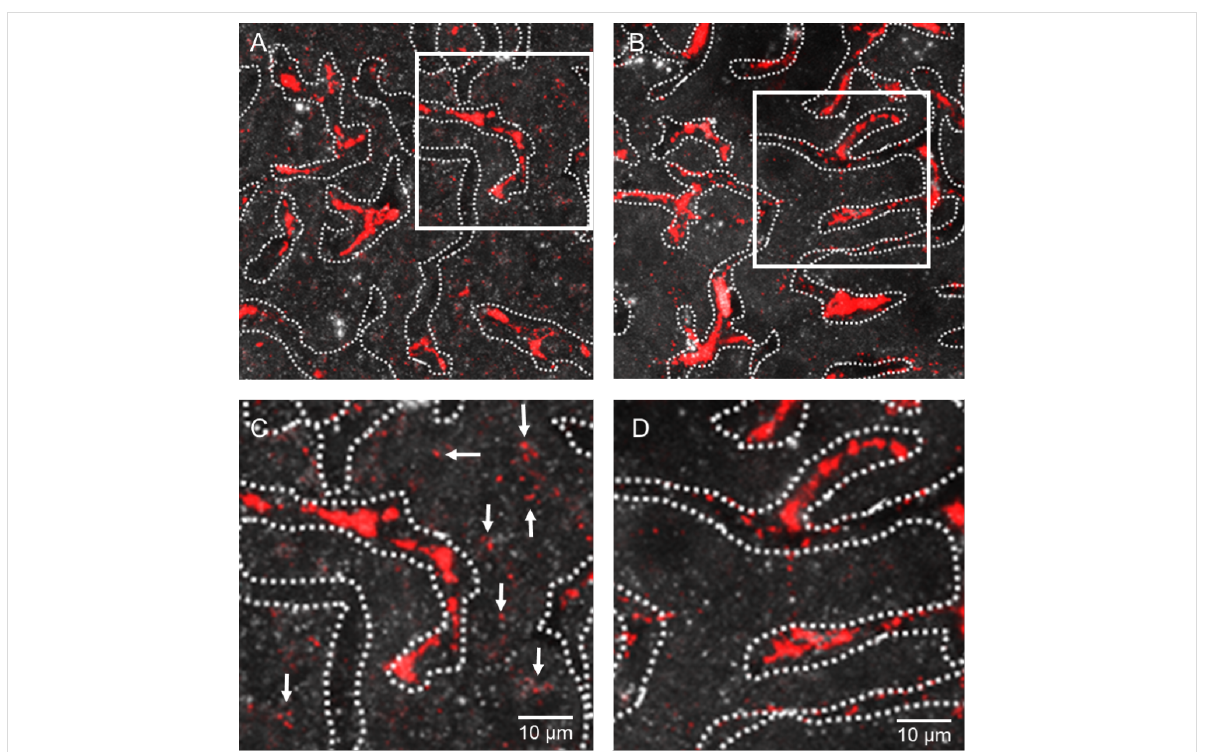
Figure 5: QDs-micelles uptake into hepatocytes is dependent on apolipoprotein E. QDs-micelles (red) were injected into wild type mice (left panel) or into apolipoprotein E-deficient mice (right panel). 30 min after injection, livers were excised and directly analysed by using confocal imaging. Liver sinusoids were visualized by the reflection mode in the unstained tissue and the capillary lumen is surrounded by dashed lines. In the wild type situa- tion, QDs-derived fluorescence were found in Kupffer cells, which are located within the lumen of liver sinusoids (A). In addition, high magnification of the highlighted square revealed uptake of QDs-micelles into hepatocytes (C, indicated by the arrows). In apolipoprotein E-deficient mice, QDs can mainly be detected within the lumen of liver sinusoids (B,D), which indicates that the QDs-micelle uptake into hepatocytes is dependent on apolipoprotein